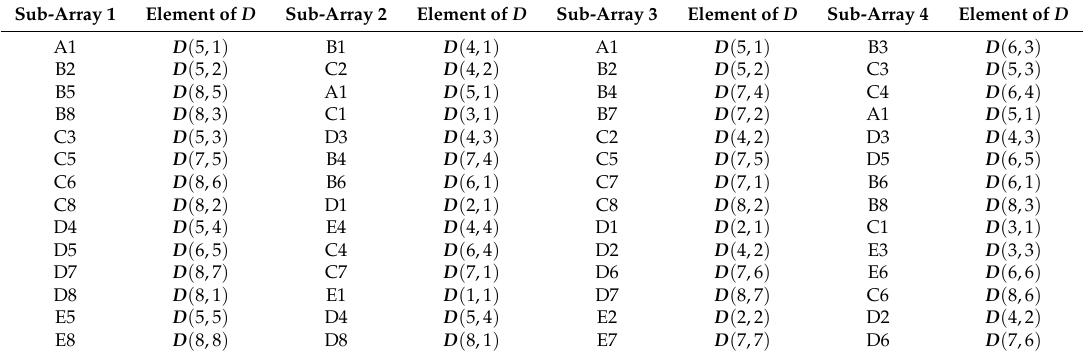
Table 1. Relationships between the elements of the virtual sub-arrays and the elements of matrix D . Sub-Array